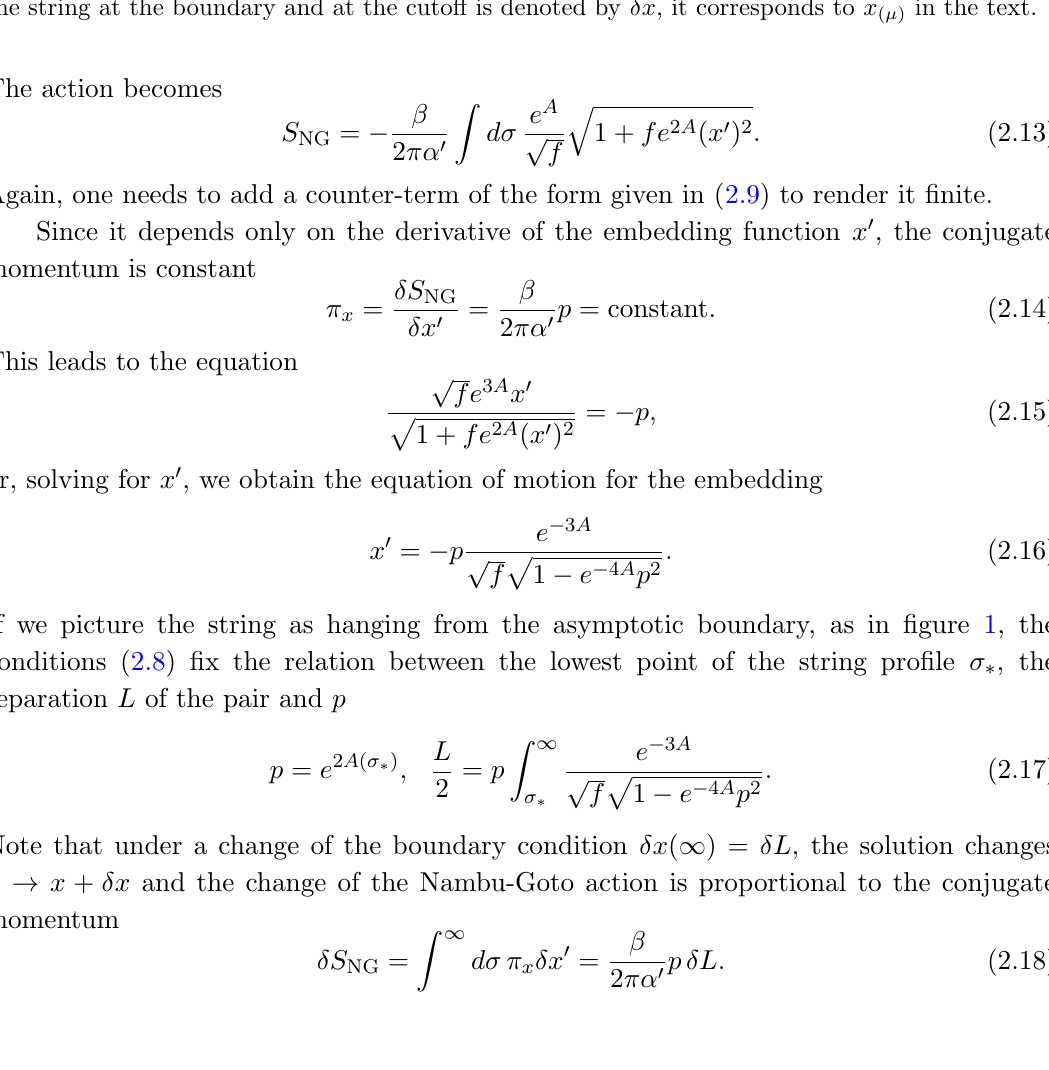
Figure 1 . Pro(cid:12)le of a string dual to a q (cid:22) q pair separated a distance ‘ (blue line). The vertical direction corresponds to the holographic radial coordinate, with the asymptotic boundary (UV) at the top. A cuto(cid:11) is introduced at an IR scale (horizontal red line) and degrees of freedom above the cuto(cid:11) are integrated out. The separation in the (cid:12)eld theory directions between the endpoint of the string at the boundary and at the cuto(cid:11) is denoted by (cid:14)x , it corresponds to x